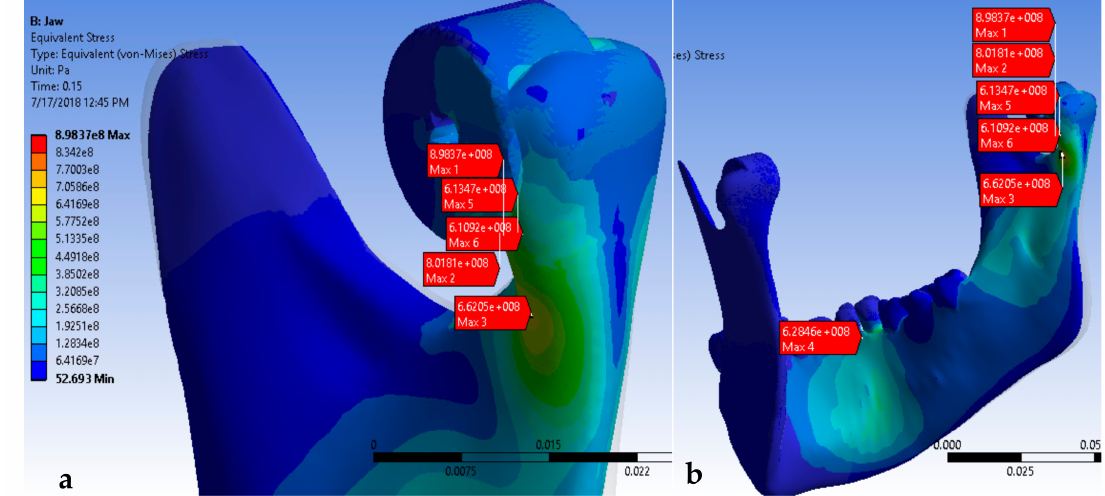
Figure 10. Stress distribution in the absence of first, second, and third molars: ( a ) condyle detail; ( b ) posterior view of the mandible: equivalent (von Mises stress) stress, unit: Pa, time: 0.15 s. Lateral Impact on Mandible with Missing the Third Molar, First and Second Premolars, and Canine